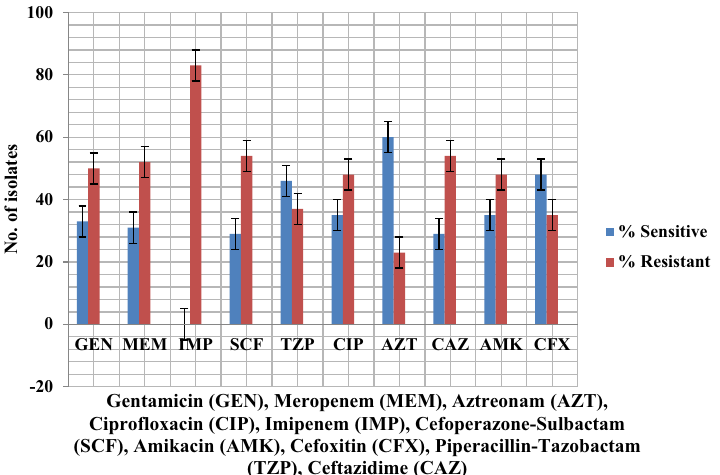
Figure 4. Antibiotic susceptibility testing of MBL producing Pseudomonas aeruginosa (n = 83). MBL metallo β-lactamase.